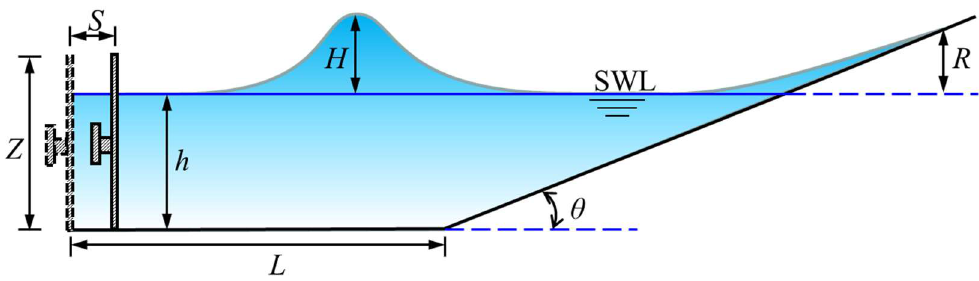
Figure 6. Set-up for solitary wave run-up on the bottom with constant slope angle. Table 1. Simulation conditions.